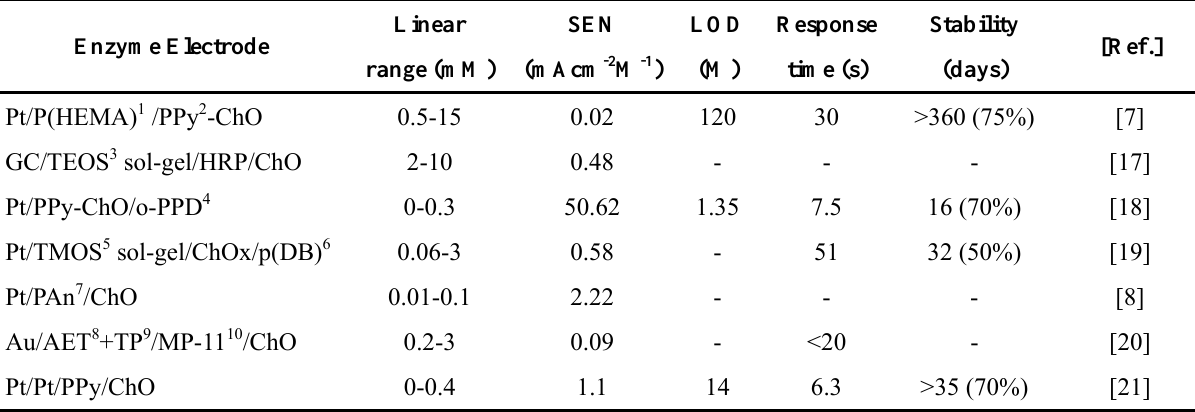
Table 1. The performance parameters of cholesterol biosensors reported in the